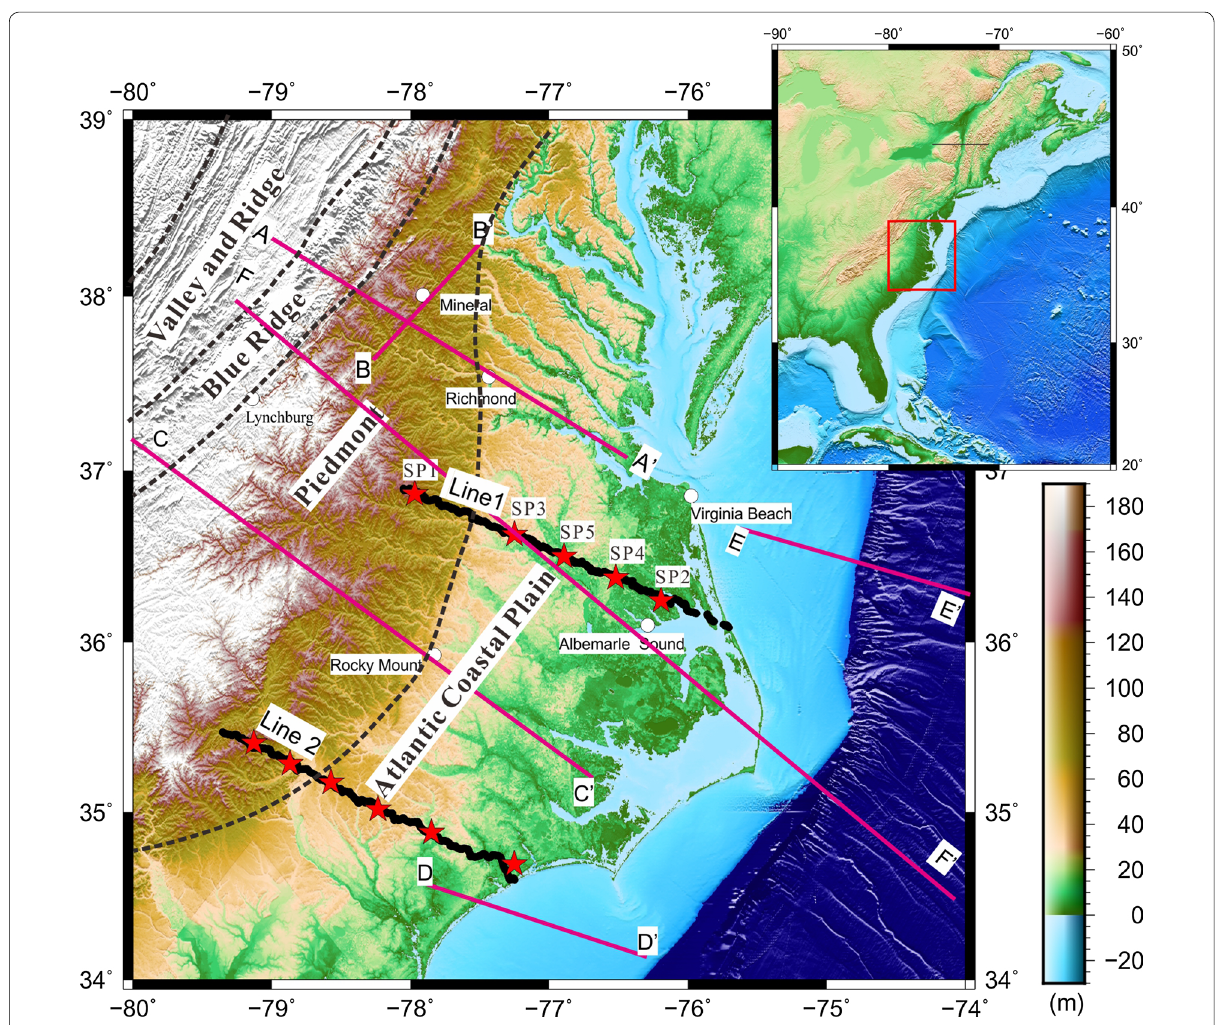
Fig. 1 Topographic map of the area showing the location of the eastern North American margin (ENAM) onshore seismic wide-angle reflection/ refraction profiles (Lines 1 and 2). The interpretation of Line 1 is presented here. Red stars represent explosion sources. Black line represents locations of portable seismographs (708 stations in Line 1). The black dashed line represents the boundary of the tectonic belts. Several earlier studies around our study area are shown in Figure: A–A ′ , a seismic reflection profile of Pratt et al. (1988, 2015); B–B ′ , crustal model of Dreiling and Mooney (2015); C–C ′ , S-wave velocity model of Shen and Ritzwoller (2016); D–D ′ , P-wave velocity model of Hales et al. (1968) and Lewis and Meyer (1977); E–E ′ , P-wave velocity model of Holbrook et al. (1994); F–F ′ : S-wave velocity model of Lynner and Porritt (2017). Red box in the inset map outlines